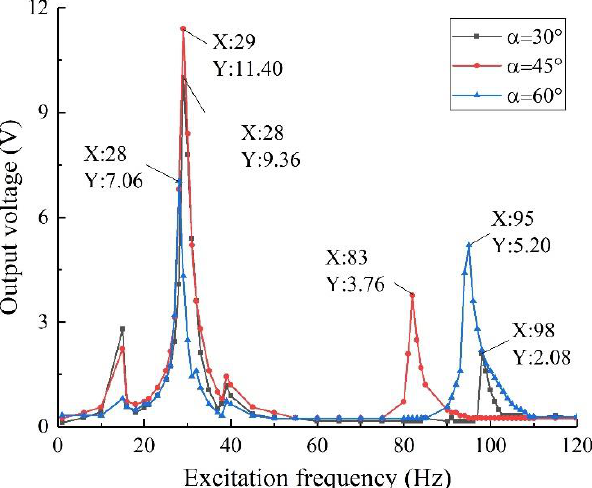
Figure 14. Output voltage with different oblique angles.